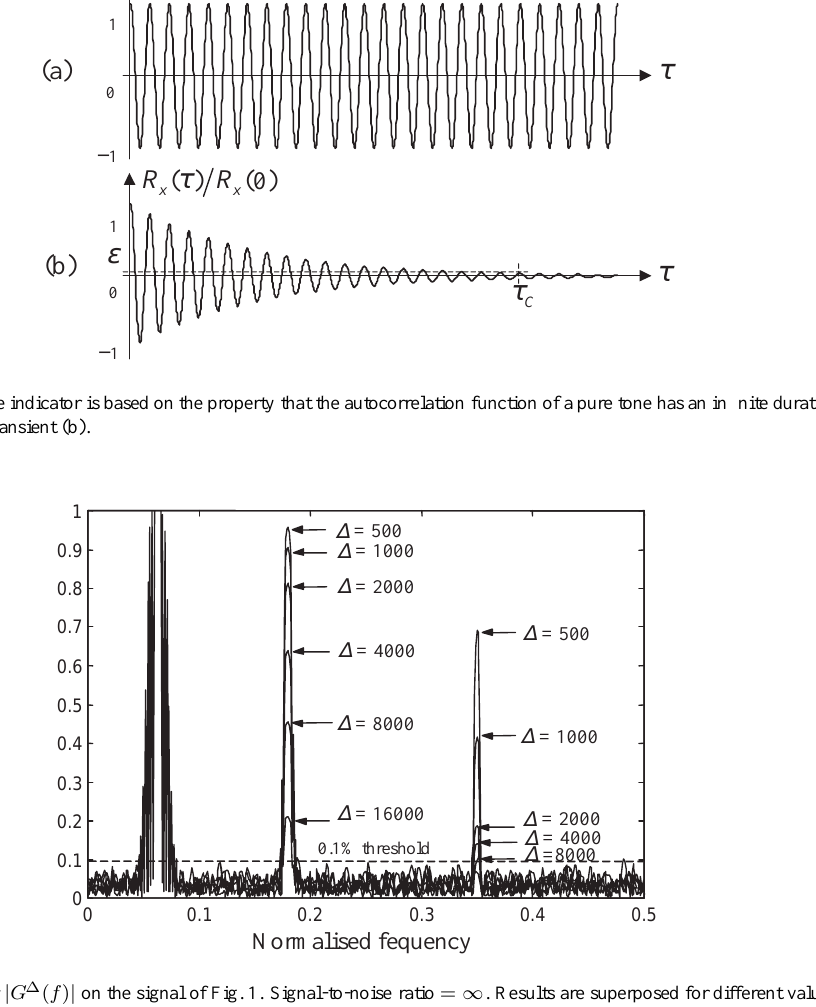
Fig. 9. Estimated indicator | G ∆ ( f ) | on the signal of Fig. 1. Signal-to-noise ratio = ∞ . Results are superposed for different values of the delay ∆ . The two resonances are revealed by the convergence to zero of the indicator, with increasing ∆ . the best predicted value is virtually zero. Therefore,